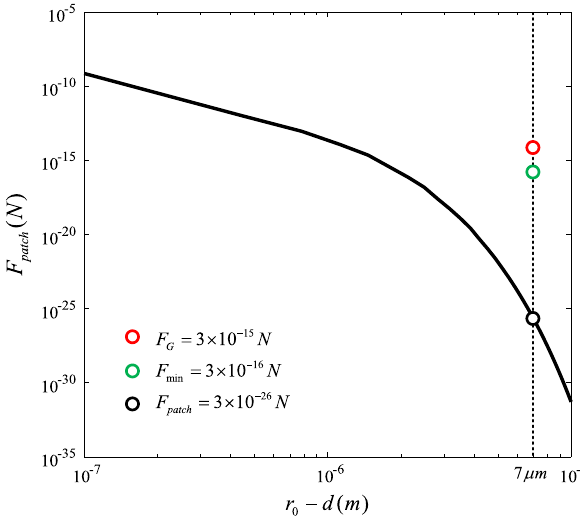
Fig. 4 Thepatchforceasafunctionofthegapbetweentwomicrodisks with thicknesses of d = 1 µ m. The red and green dots show the gravity force of 4+2 dimensions and the sensitivity of measurement, respec- tively, in the separation of r 0 = 8 µ